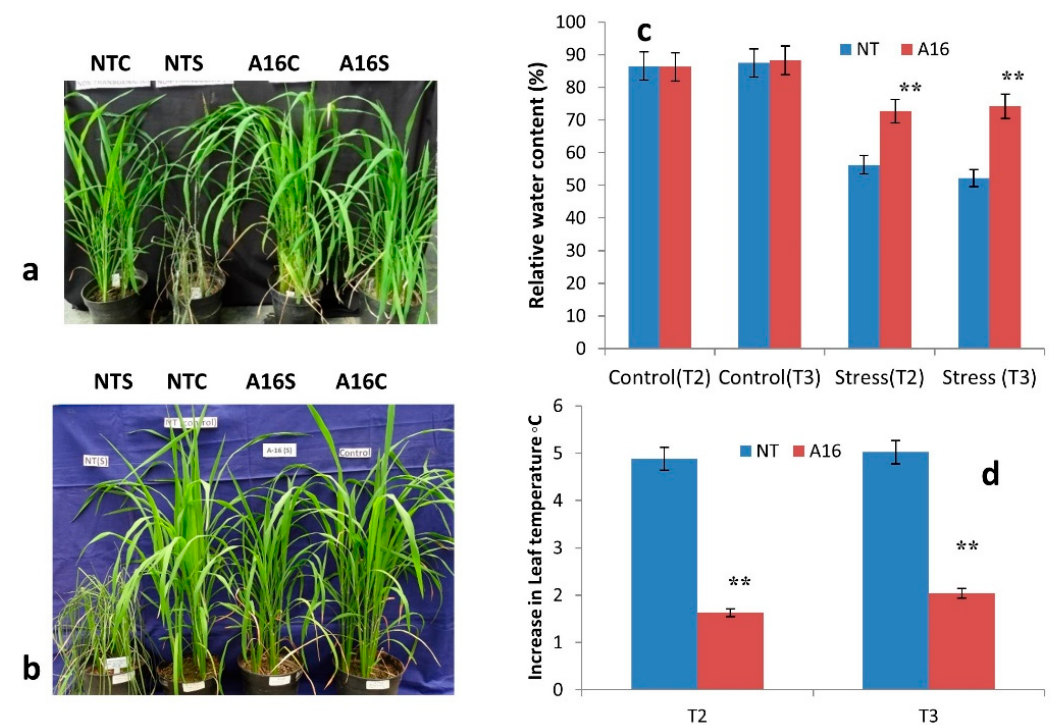
Figure 8. Responses of ADT 43 non-transgenic (NT) and transgenic (# A16) line (T 2 and T 3 progenies) to drought stress; ( a ) Performance of # A16 (T 2 ) at 12 DAIS; ( b ) Performance of # A16 (T 3 ) at 14 DAIS; NTC, Non-transgenic control; NTS, Non-transgenic stress; A16C, Control plants of # A16; A16S, Stressed plants of # A16; ( c ), Relative water content in the leaves of Non-transgenic and transgenic ADT 43; ( d ) increase in the leaf temperature of stressed plants over the respective controls; The values in the graph are the mean of three replications. ** indicates statistical significance at p < 0.01 (ANOVA compared to non-transgenic drought-stressed).